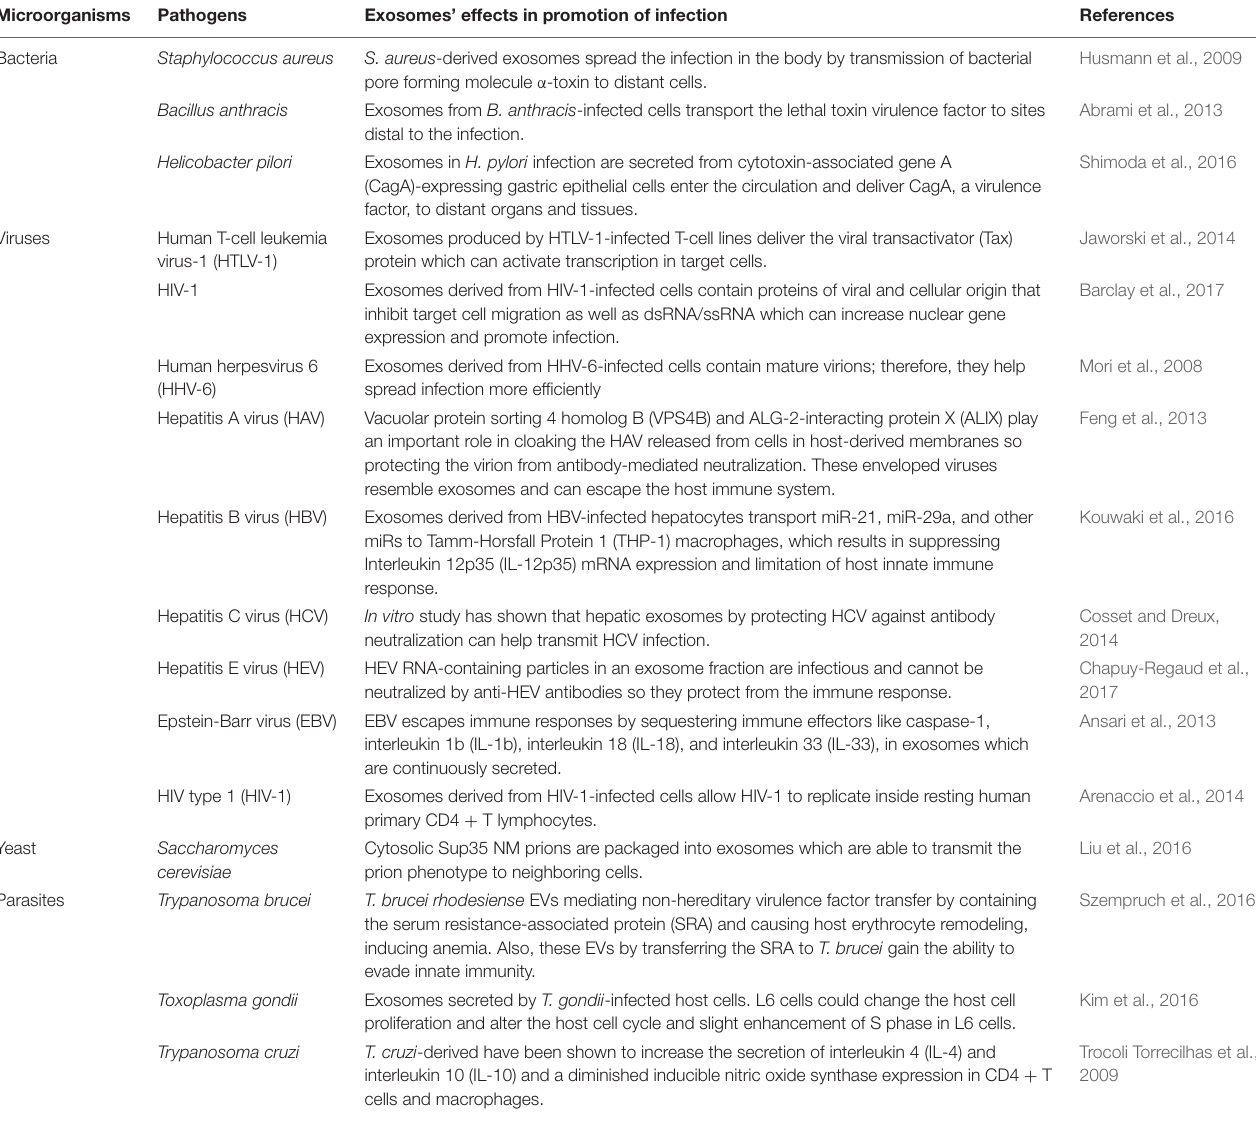
TABLE 1 | The role of exosomes in the development of infections caused by various